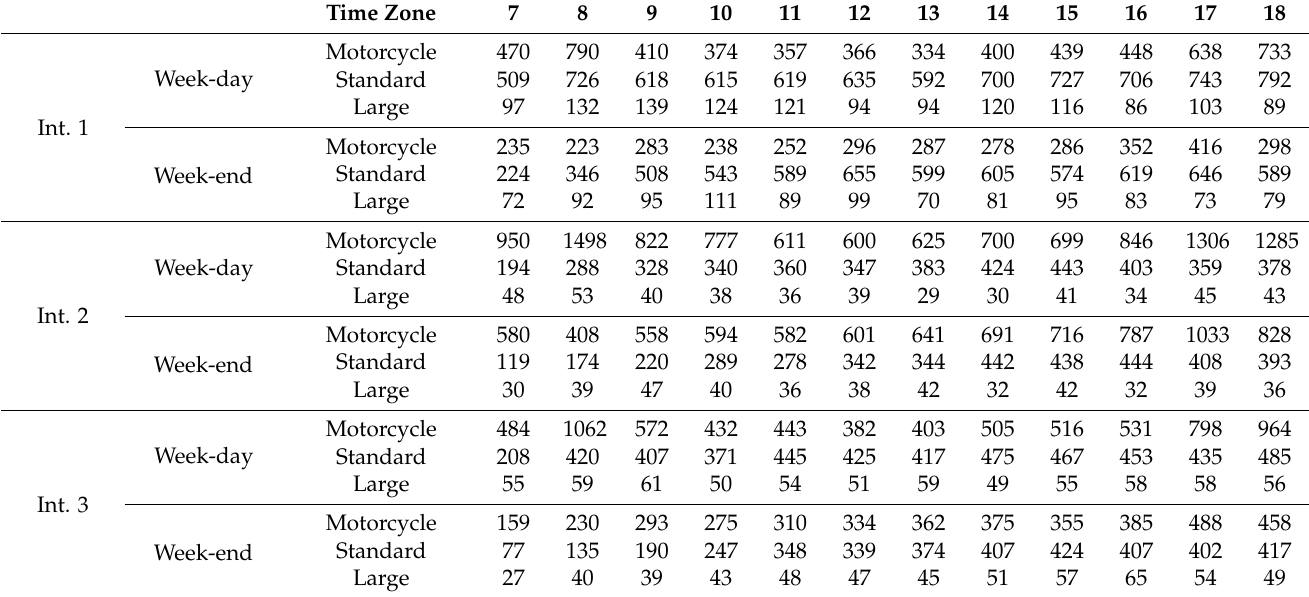
hours (i.e., around 8:00 in the morning and 17:00 or 18:00 in the evening) on weekdays at all intersections, while that on the weekend gradually increased from morning to